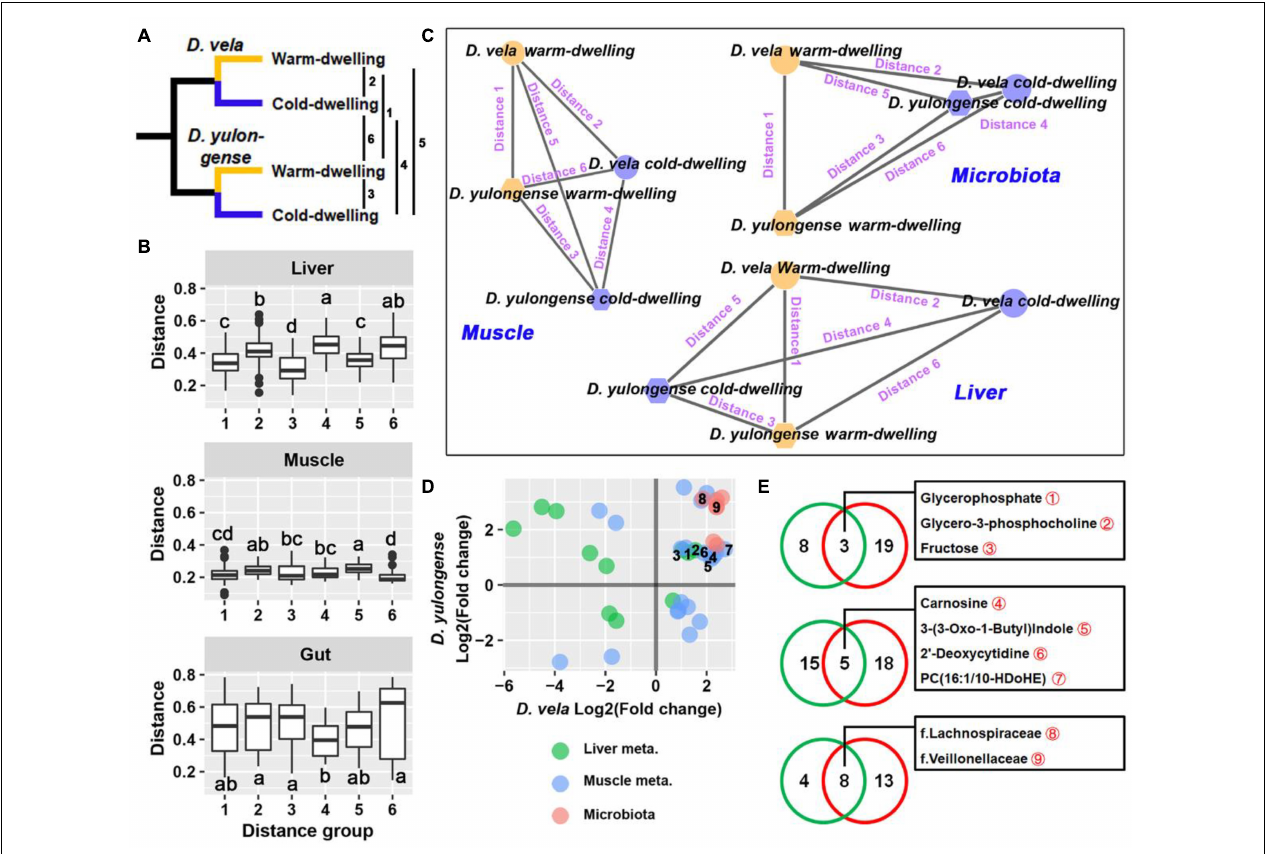
FIGURE 6 | Intraspecies comparisons between cold- and warm-dwelling populations. (A) D. vela and D. yulongense individuals could be divided into cold- (DV-1, DY-1, and DY-2) and warm-dwelling populations (DV-2, DV-3, DY-3, and DY-4) according to the annual temperature. The distances between populations ranged from 1 to 6. (B) Distances between cold- and warm-dwelling species. Metabolome: Bray-Curtis distance; microbiome: weighted UniFrac distance. (C) Topological networks present the relative distances between groups. Note that a cold environment drives the opposite, parallel, and concurrent variations in the liver, muscle, and gut microbiome, respectively, between D. vela and D. yulongense . (D) Point plot presenting the variation patterns of metabolites and microbes, which differed significantly between cold- and warm-dwelling populations in both species. The horizontal and vertical axes denote the fold changes of cold- to warm-dwelling populations in D. vela and D. yulongense , respectively. Points with numeric numbers are annotated in panel (E) . (E) Venn plots presenting the number of metabolites associated with the environmental temperature. Green circle, metabolites or microbes screened by correlation analyses across species ( q < 0.05 for Pearson correlation and p < 0.05 for Spearman correlation); red circle, metabolites or microbes filtered by intraspecies comparisons between cold- and warm-dwelling populations ( p < 0.05 for Mann–Whitney U -test in both